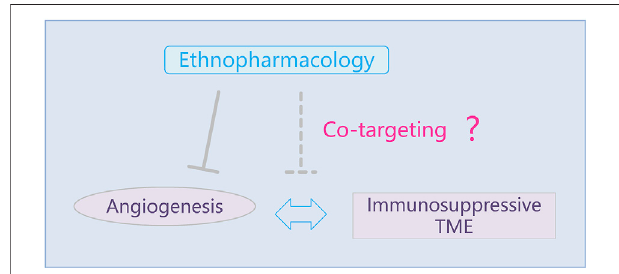
FIGURE 1 | Potential and promising candidates were revealed for anti- angiogenic therapy, including traditional Chinese medicine. The attractive perspective that co-regulating angiogenesis and immunosuppressive tumor microenvironment via natural products and its derivatives or delivery system is proposed under the frame of